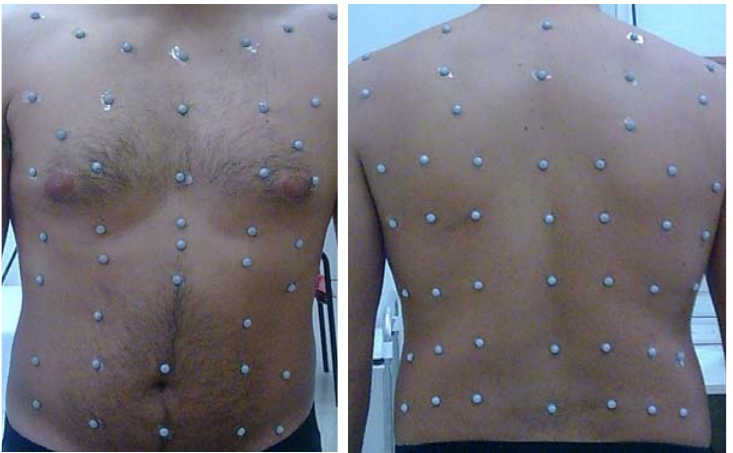
Figure 1. 89 marker model for respiratory acquisition. 42 markers are placed in front and 47 on the back of the